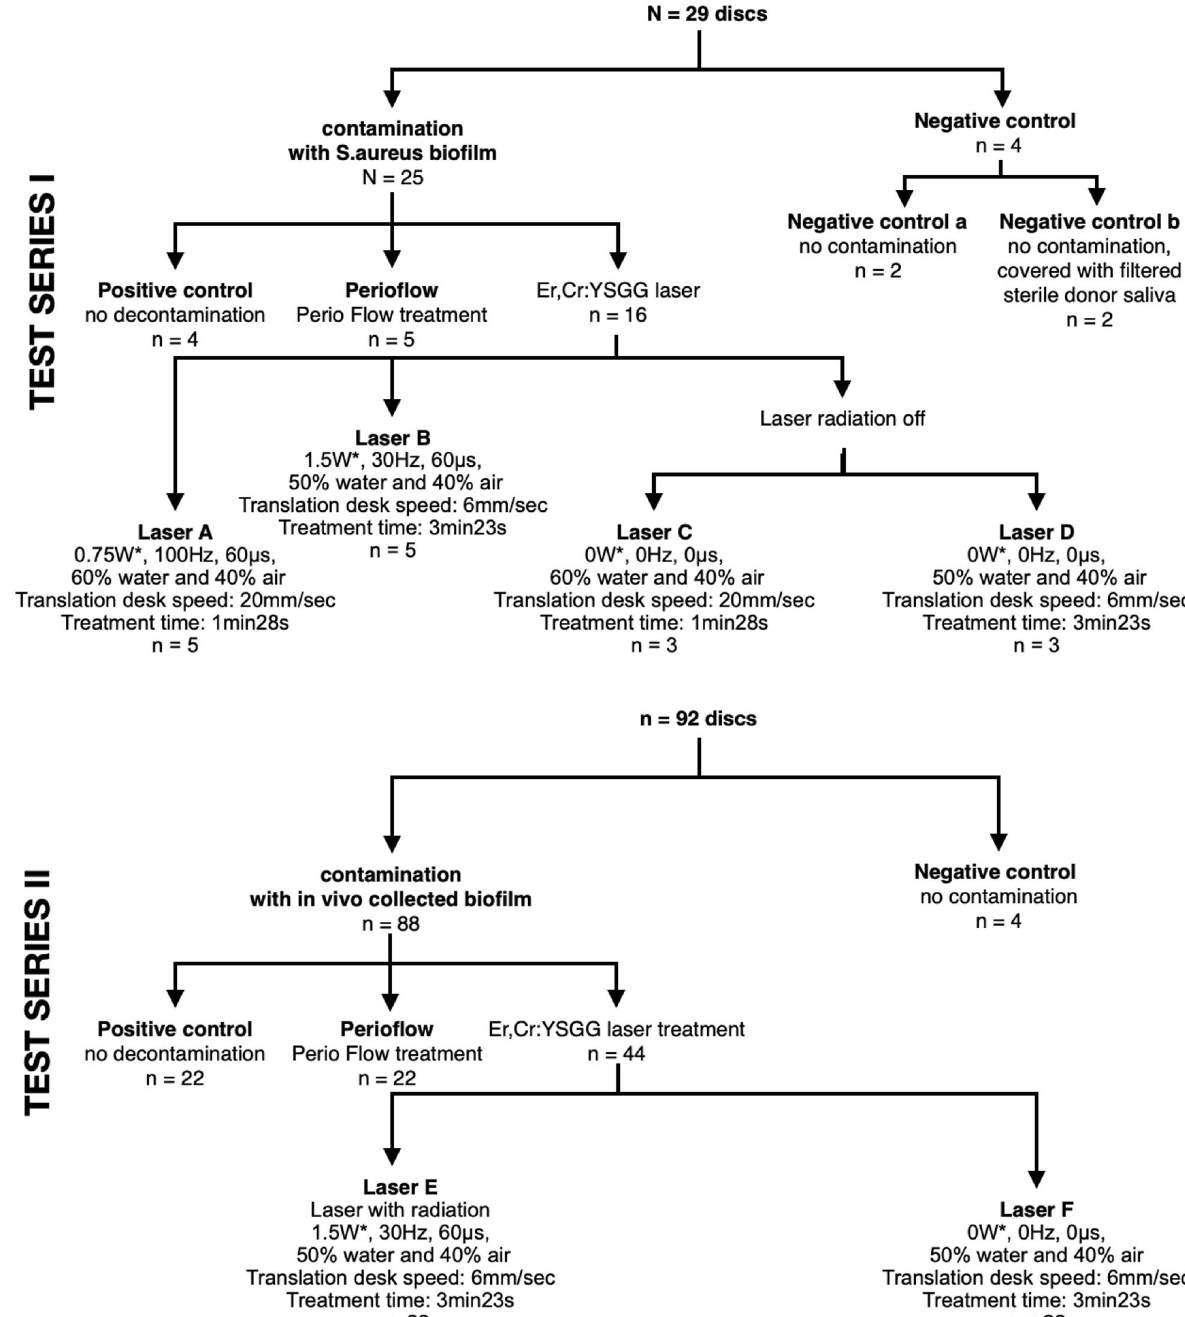
Fig. 1 Groups distribution for the Test Series I and II. (Asterisk) The side firing tip’s calibration factor of 0.95 is not